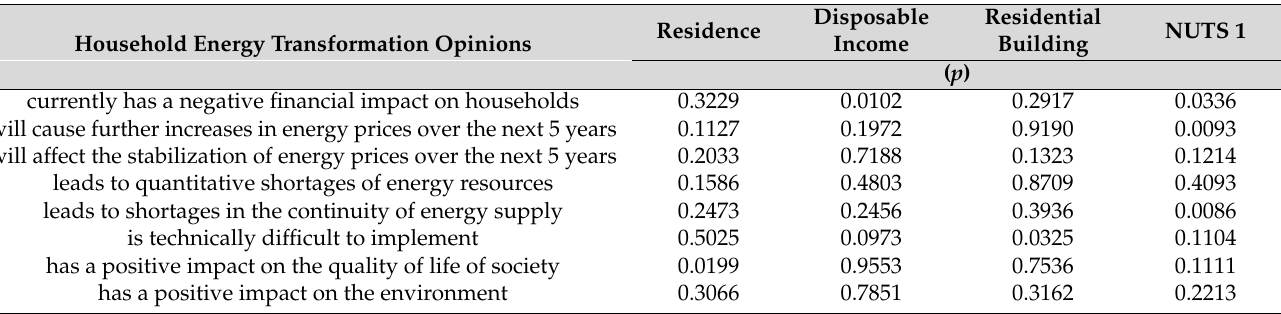
Table 8. Energy transition opinions and selected characteristics from the metric (Kruskal–Wallis ANOVA and Mann–Whitney U test